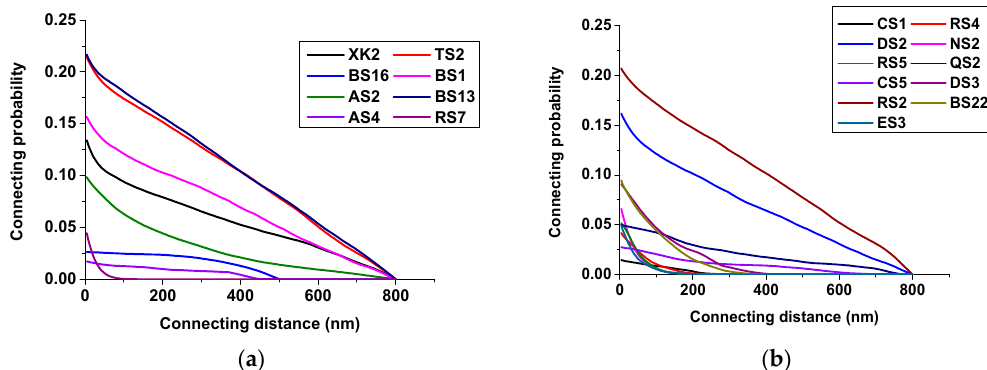
Figure 17. ( a ) Pore connectivity of organic matter in shallow samples, ( b ) Pore connectivity of organic matter in deep samples.